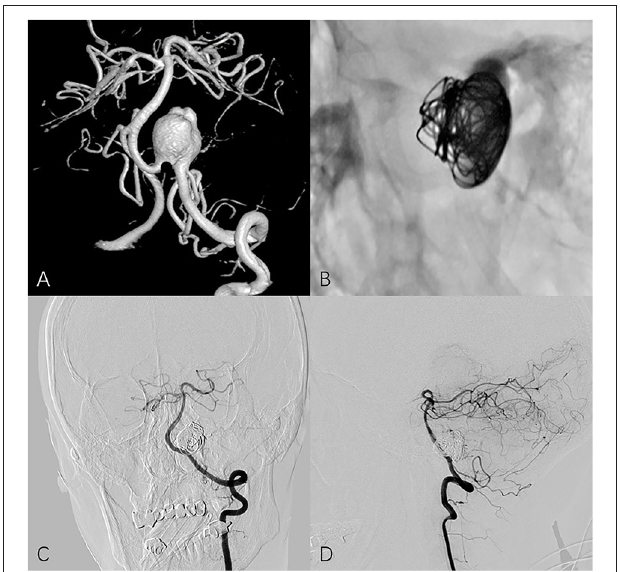
FIGURE 3 | Fifty four year-old female with bilateral vertebral aneurysm. (A) Frontal angiogram of the left vertebral artery shows bilateral dissecting aneurysm and the left involved PCIA. (B) Non-subtracted frontal view shows bilateral PED in place. (C) The 25-month follow-up left (C) and right (D) angiogram indicates left vertebral artery is occluded at V3 segment and PICA remains patency through contralateral circulation.